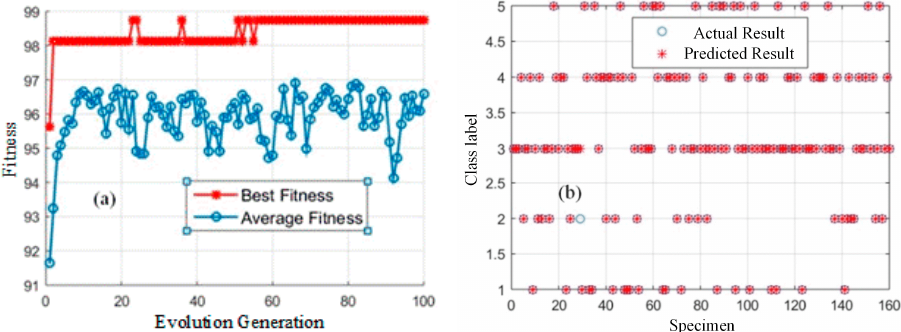
Figure 8. GA-optimized PCA-SVM for aging stage assessment of oil-paper insulation: ( a ) The fitness curve of seeking the best C and γ by GA; ( b ) Classification results of the training samples.